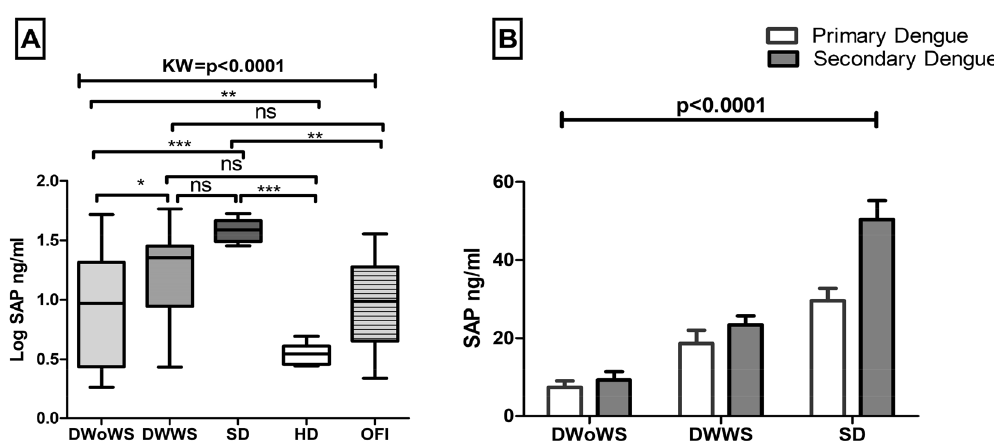
Figure 3. ( A ) Levels of Serum Amyloid P (SAP) protein of dengue without warning sign (DWoWS), dengue with warning signs (DWWS) severe dengue (SD) and Other febrile infection (OFI). Study subjects are significantly different from each category. ( B ) Levels of SAP of primary and secondary dengue infection. Study subjects are significantly different from each category is indicated by P < 0.05. Statistical analysis was performed using the Graph-Pad Prism statistics software (Graph-Pad Software Inc., San Diego, CA, USA free demo version